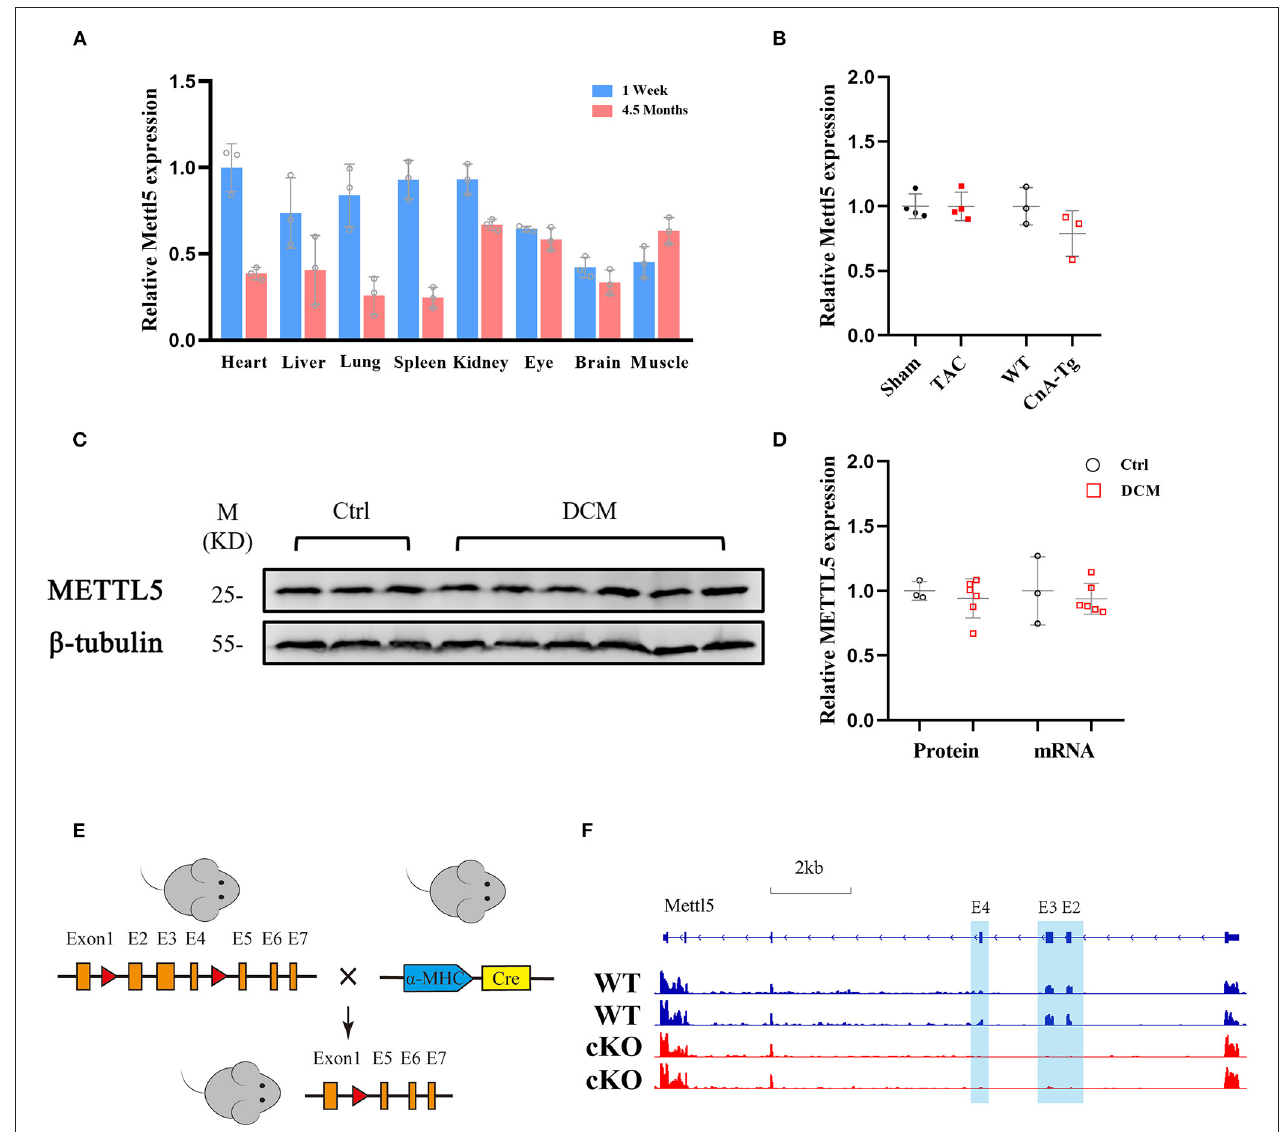
FIGURE 1 | METTL5 expression profile and the generation of METTL5-cKO mouse. (A) Relative gene expression of METTL5 in different organs from 1 week and 4.5 months old mice by RT-PCR. n = 3 mice in each group. (B) Relative gene expression of METTL5 in TAC vs. Sham ( n = 3 mice in each group) and CnA-Tg vs. WT ( n = 4 mice in each group) mouse hearts by RT-PCR. (C) The protein level of METTL5 in control patient hearts ( n = 3) and dilated cardiomyopathy (DCM) patient hearts ( n = 6) by western blotting. β -tubulin srerves as a control. (D) Quantification of western blotting in panel C and the relative expression of METTL5 in control patient hearts ( n = 3) and DCM patient hearts ( n = 6) by RT-PCR. (E) Schematic of generation of METTL5 cardiomyocyte-specific knockout (METTL5-cKO) mouse. (F) The genomic view of reads in RNA-seq for METTL5 in the IGV browser.